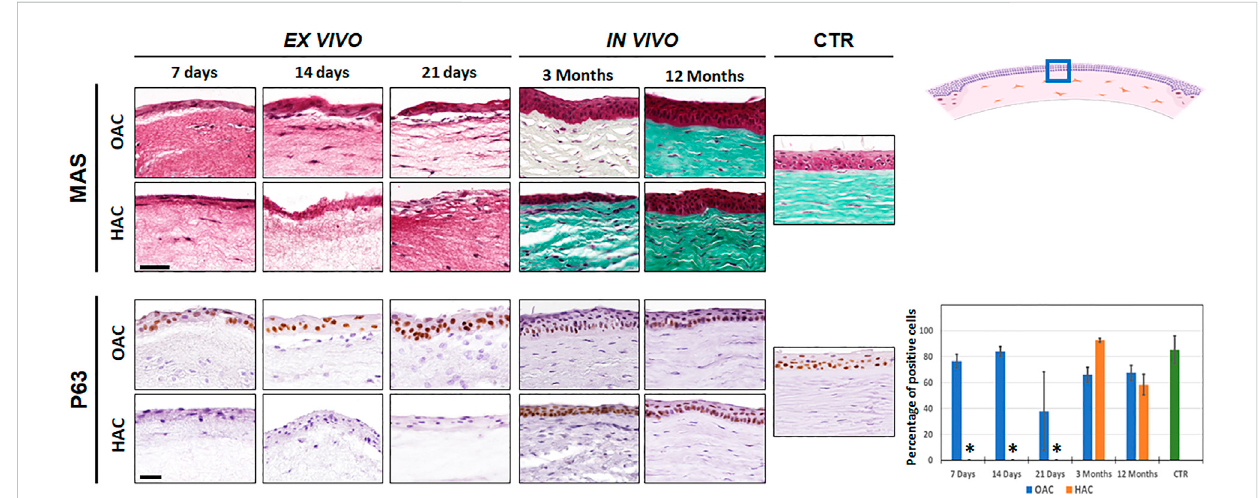
FIGURE 2 Histologicalevaluationoforthotypical(OAC)andheterotypical(HAC)arti fi cialcorneasandcontrols.Thetoppanelcorrespondstotheanalysisusing Masson ’ s trichrome staining (MAS), whereas the lower panel shows the immunohistochemical analysis of p63. In both cases, the area in which the in vivo histological images were obtained is labeled with a blue square in the illustration representing the rabbit cornea shown at the upper right corner. Bioarti fi cial corneas kept ex vivo for 7, 14 and 21 days, and corneas grafted in vivo for 3 and 12 months are shown. Controls (CTR) correspond to native, normal human corneas. Scale bars: 50 µm (applicable to all images). The histogram corresponding to the p63 panel shows the results of the quantitativeanalysisofthepercentageofpositivecellsineachgroup.Asterisksrepresentstatisticallysigni fi